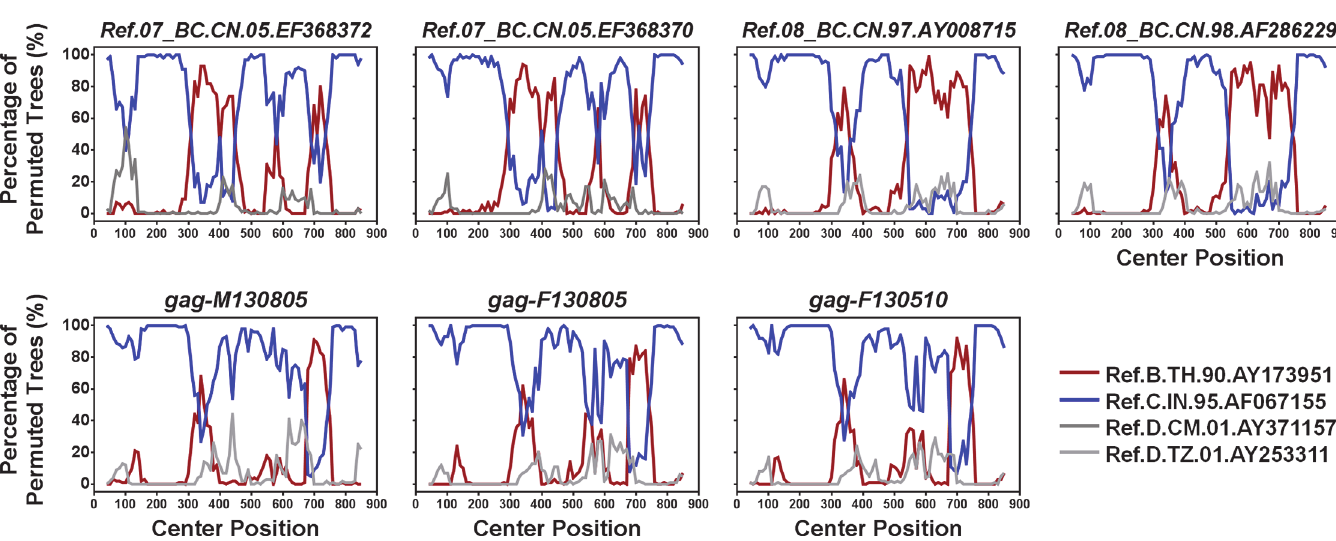
Fig 2. Bootscanning analysis of possible intertype mosaicism. Window: 80 bp, step: 10 bp, GapStrip: on, reps: 100, Kinura (2-parameter), T/t: 2.0. The reference sequences are shown at the bottom right of the figure.